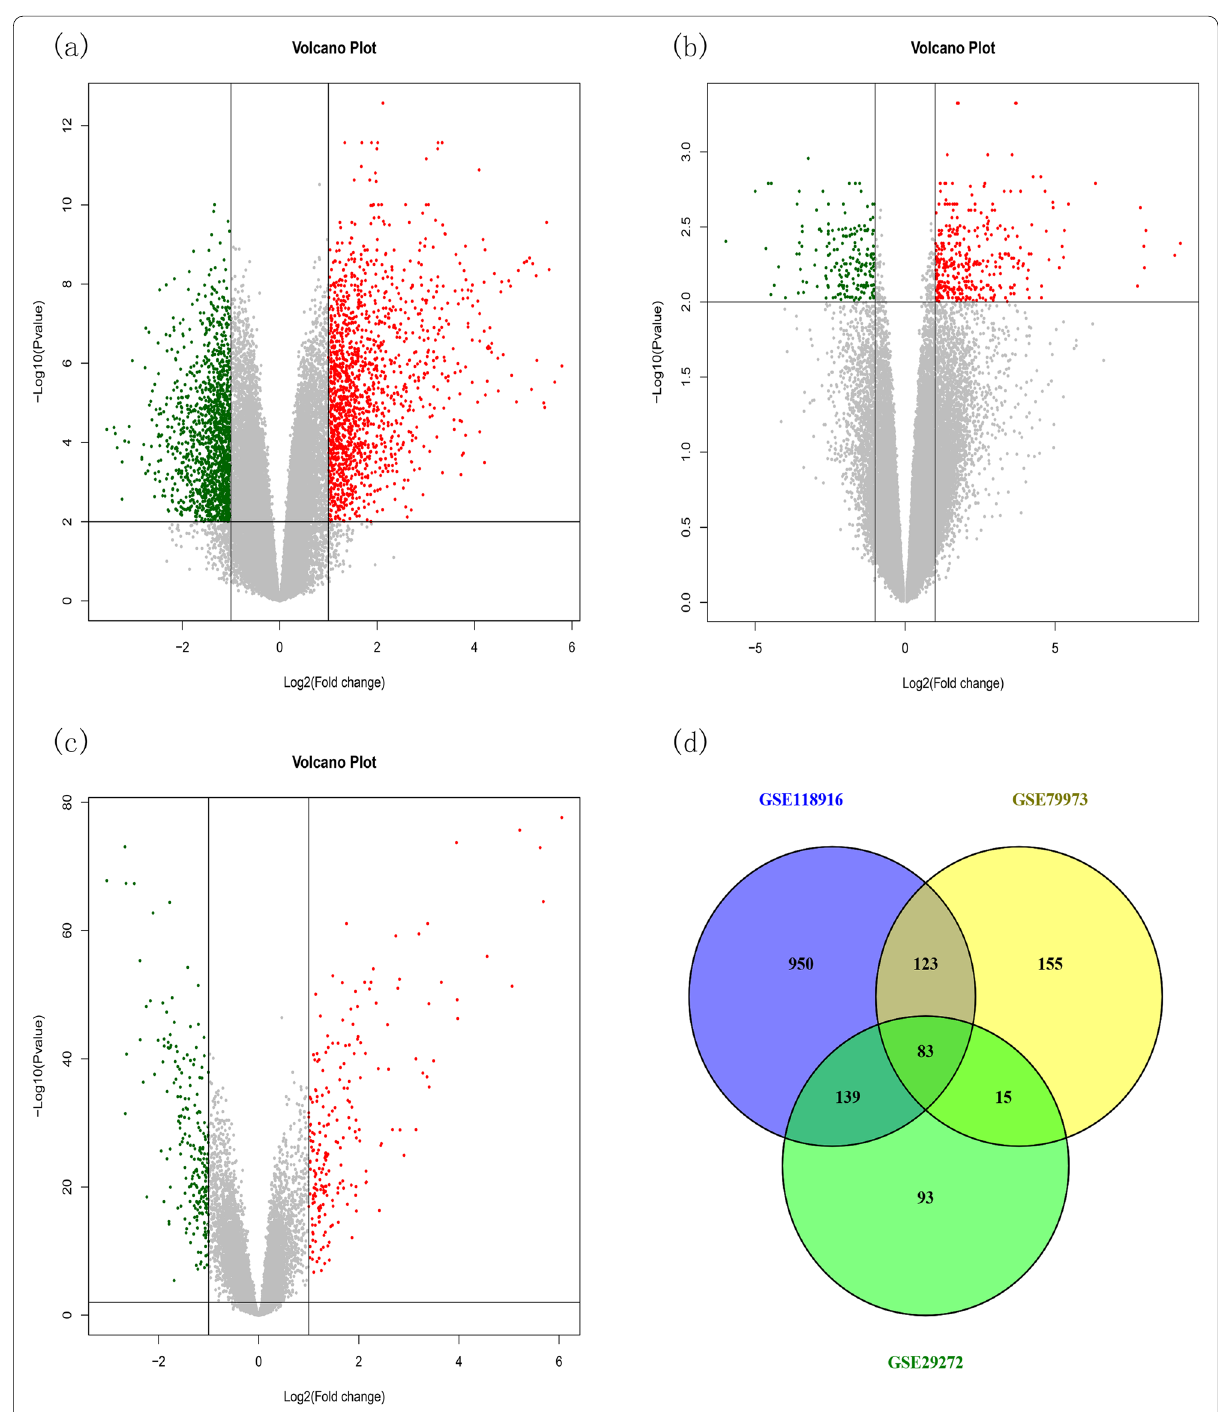
Fig. 1 Identification of DEGs among each GEO data set. a – c The volcano plots of the distribution of DEGs in each data set. d Authentication of 83 common DEGs in the three datasets (GSE118916, GSE79973, and GSE29272) through Venn diagram software (available online: https:// bioin fogp. cnb. csic. es/ tools/ venny/ index.